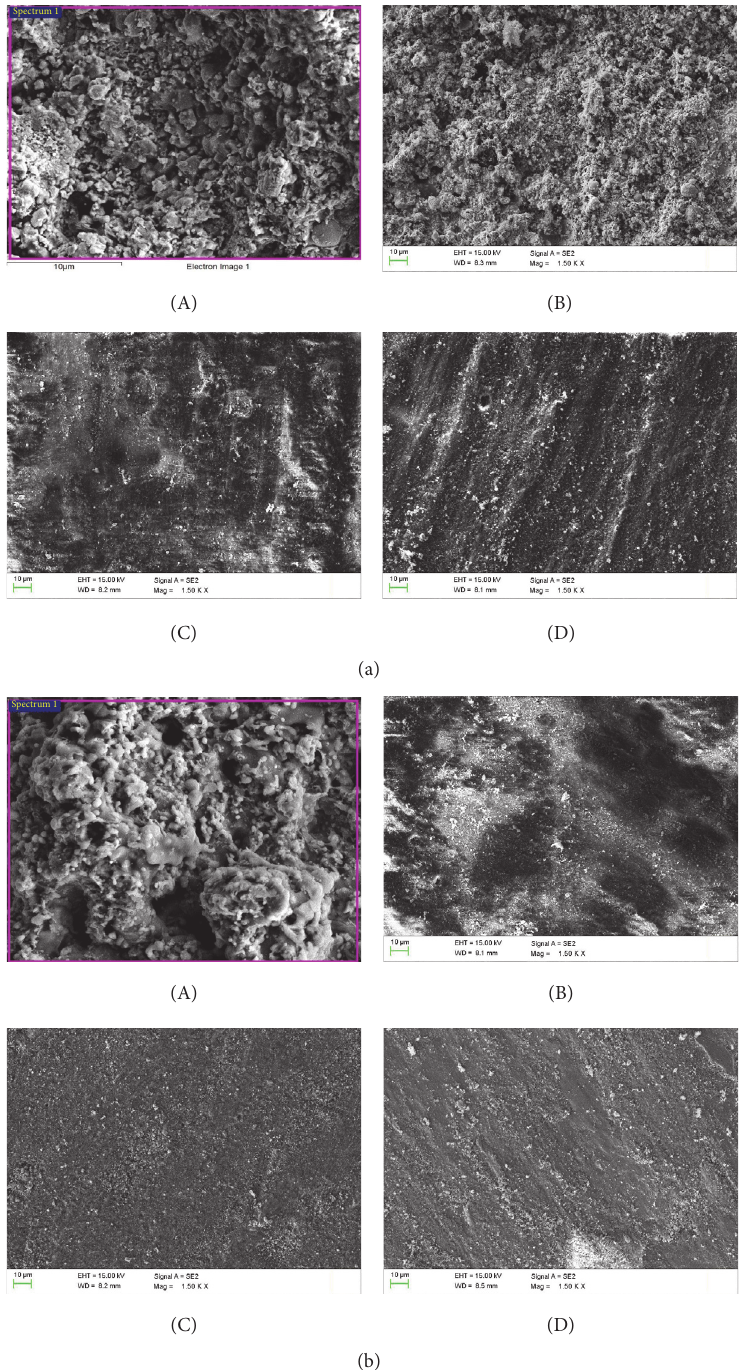
Figure 3: (a) SEM images of D-Gun sprayed WC-12% Co coating showing: (A) Unworn surface; (B) Surface worn under a load of 40 N; (C) Surface worn under a load of 50N; (D) Surface worn under a load of 60 N. (b) SEM images of D-Gun sprayed Cr 3 C 2 -25% NiCr coating showing: (A) Unworn surface; (B) Surface worn under a load of 40N; (C) Surface worn under a load of 50 N; (D) Surface worn under a load of 60